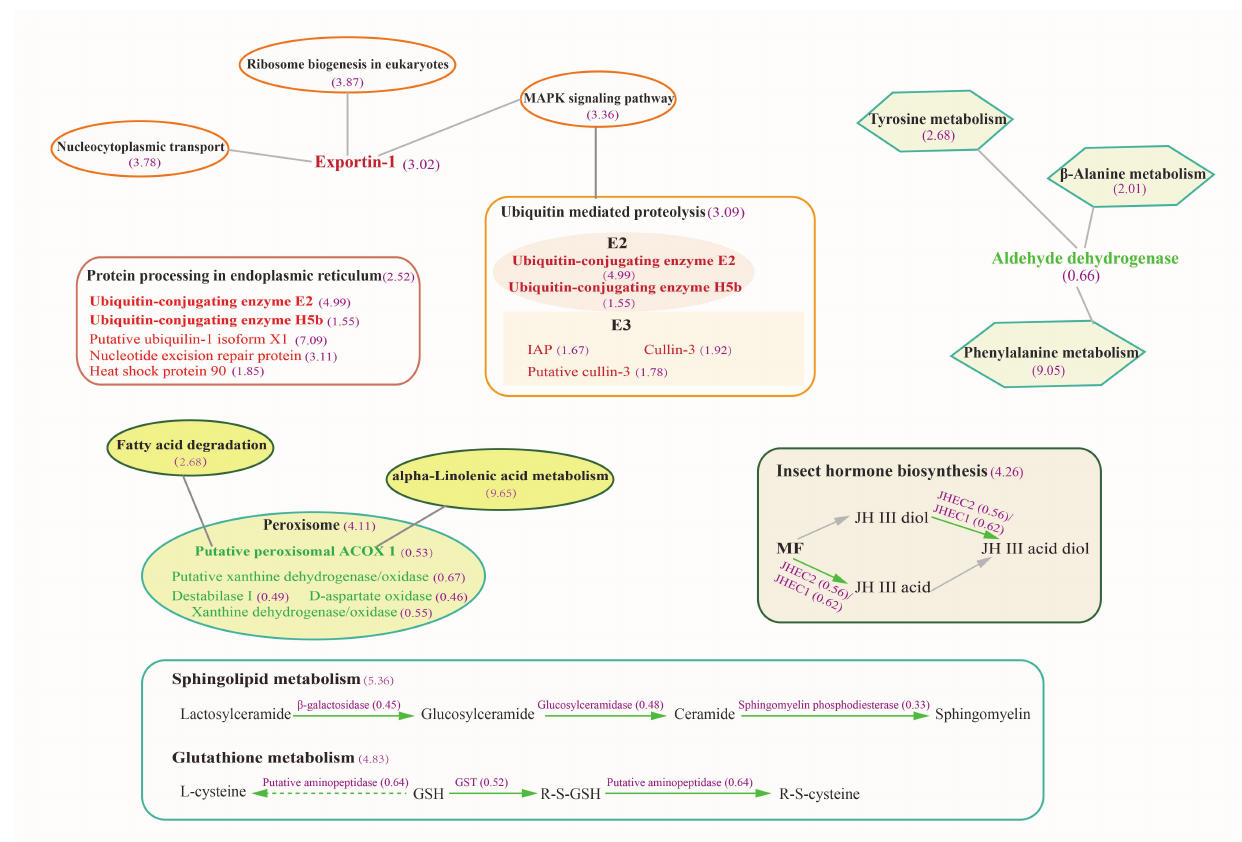
Figure 5. Summary of the main differentially regulated pathways between the H and L group. Green-colored ellipses, rectangular frames, and polygons indicate down-regulated pathways. In comparison, the orange-colored ones indicate up-regulated processing. Purple-colored ones indicate the participant enzymes or the fold enrichment value of metabolism pathways, and the value in brackets represents the ratio of H to